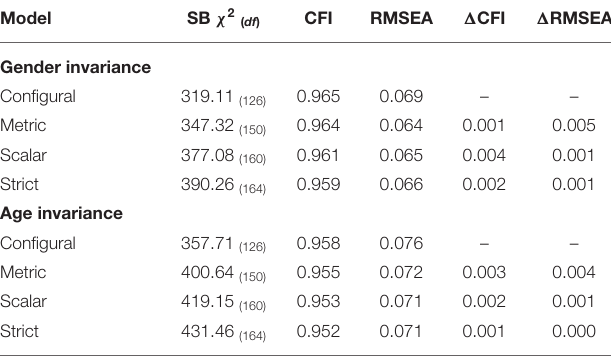
TABLE 3 | Measurement invariance of the bifactor model across gender and age.